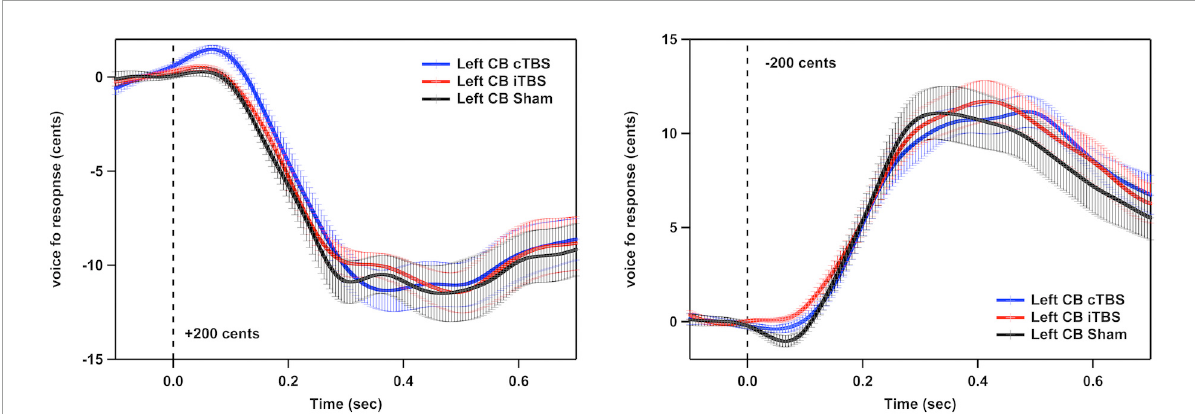
FIGURE3 Grand-averaged voice f o contours across all participants in responses to pitch perturbations of ± 200 cents following continuous theta burst stimulation (cTBS) (blue), intermittent theta burst stimulation (iTBS) (red), and sham (black) stimulation over the left cerebellar lobule VII (Crus I). Time 0 represent the onset of pitch perturbations. CB, cerebellum.